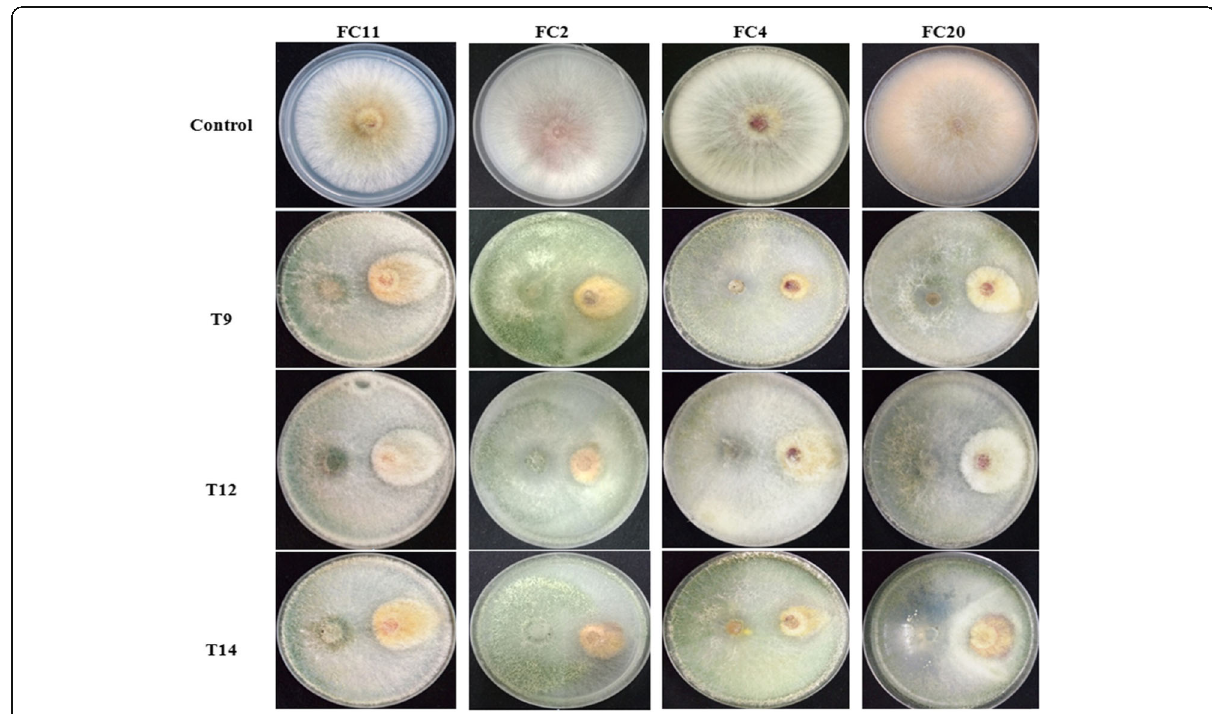
Fig. 2 Direct in vitro confrontation between Trichoderma isolates (T9, T12, and T14) against strains of F. culmorum (FC11, FC2, FC4,